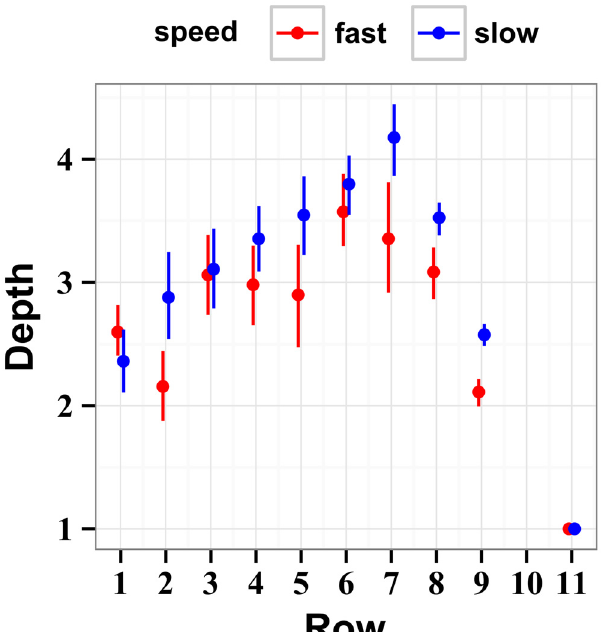
Fig 10. Depths of computation estimated using only unambiguous path overlaps. The unambiguous recovery of depth of computation d from human choices is achieved by taking into account only those choices that overlap with just one ideal path. (Row 10 had no such overlaps). The estimates of d based on the certain choices do not suffer from the artificially inflated evidence for d = 1 observed in Fig